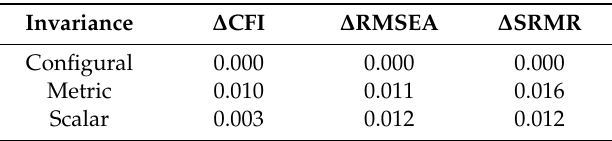
Table 3. Results of invariance analyses across gender.